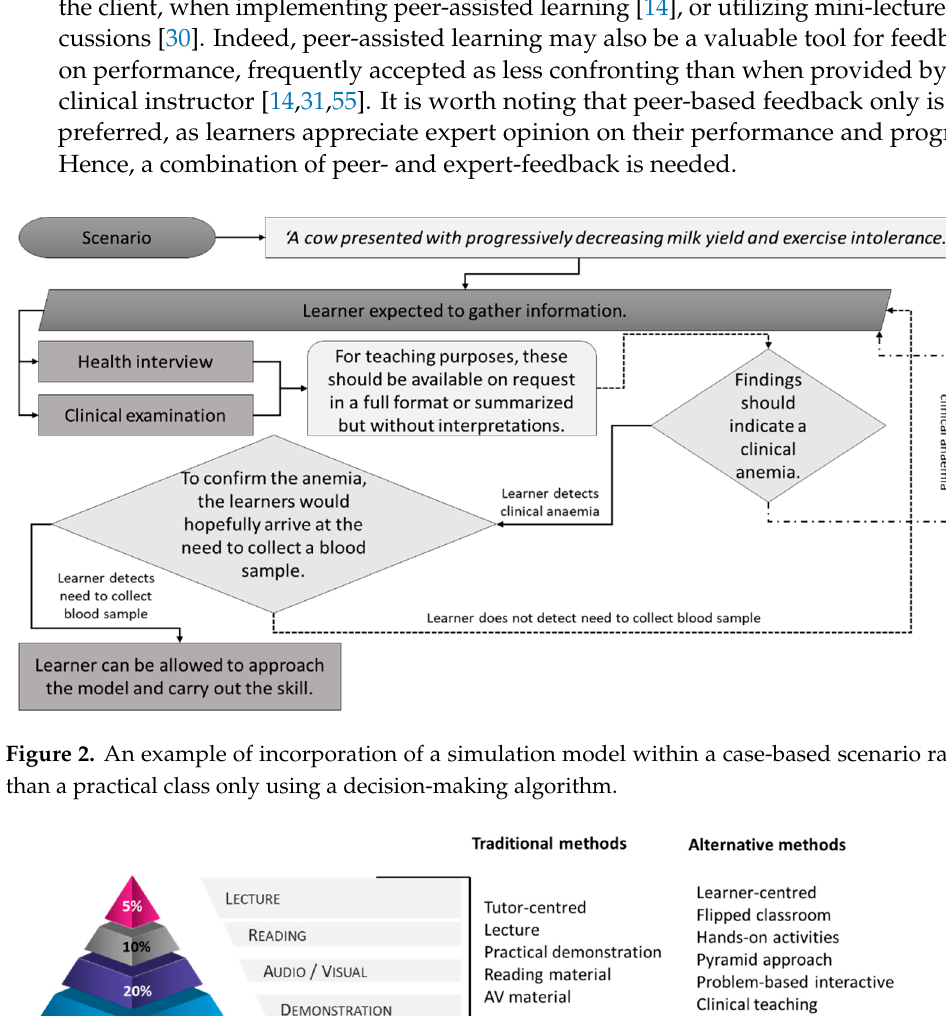
Figure 2. An example of incorporation of a simulation model within a case-based scenario rather than a practical class only using a decision-making algorithm.